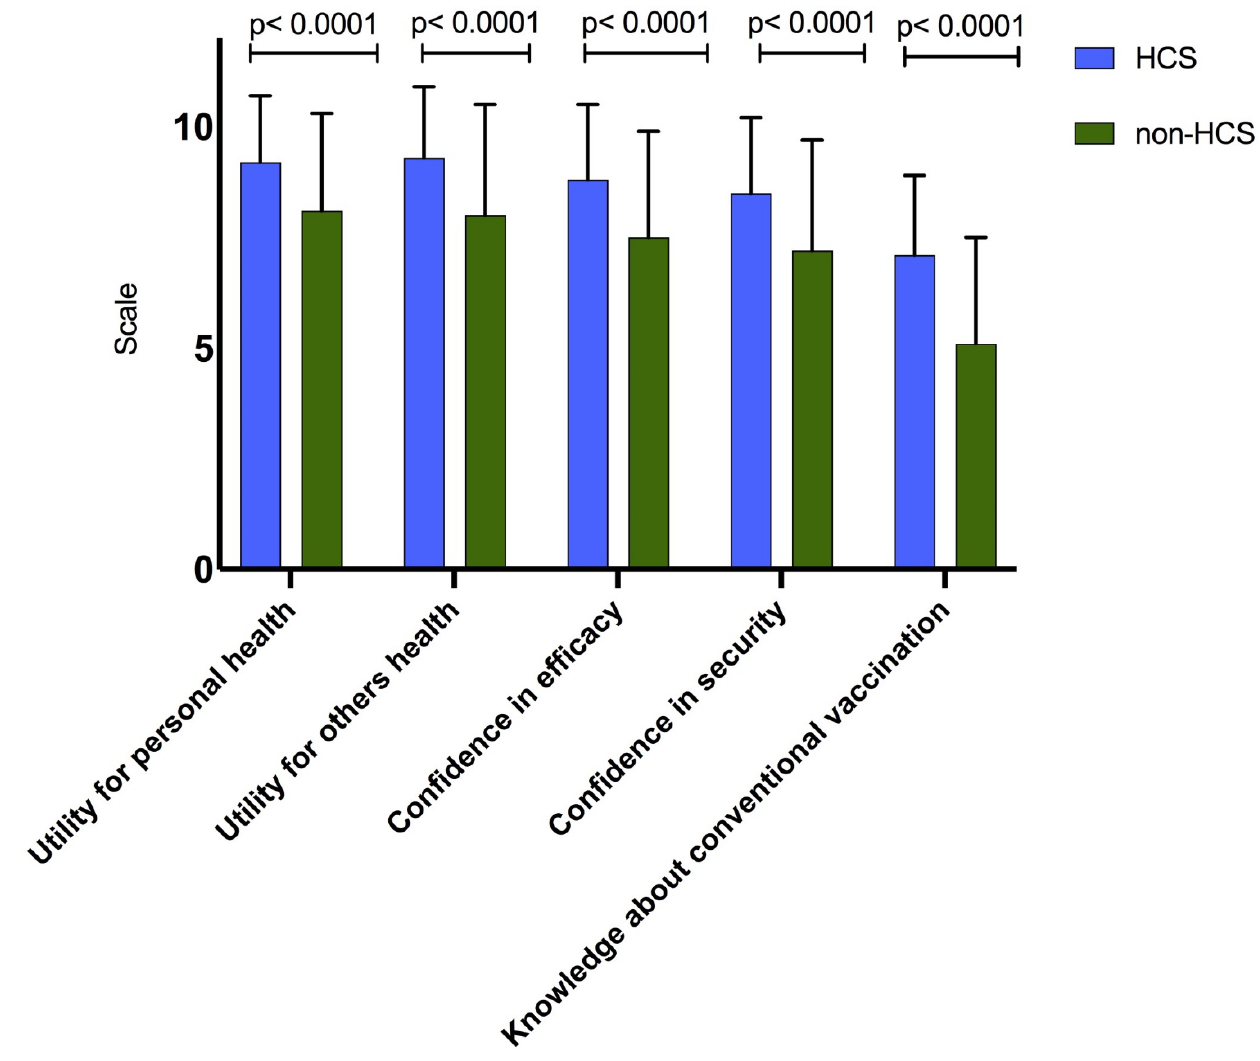
Figure 1. Utility, confidence and knowledge in vaccines among university students in France ( n = 3089). HCS: Healthcare students.